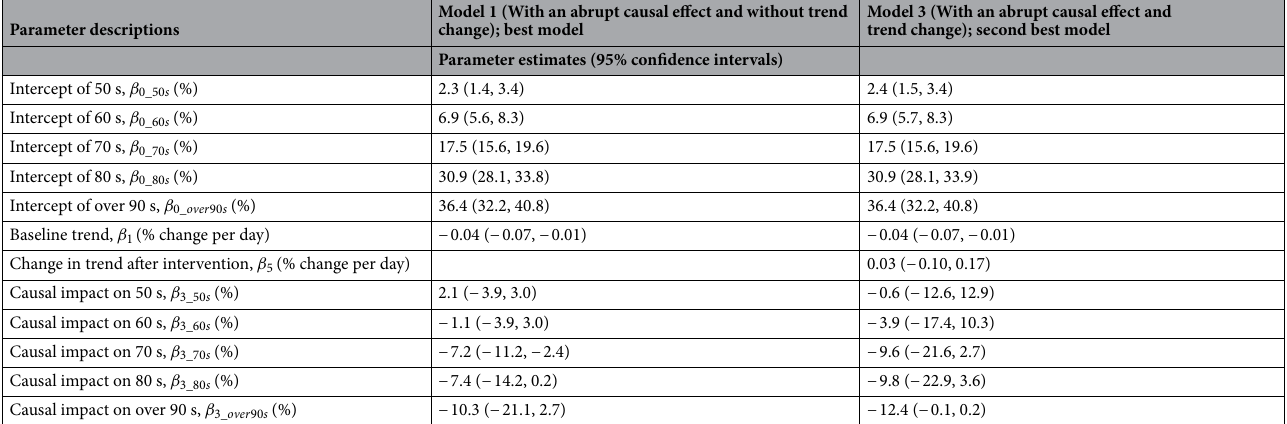
Table 2. Parameter estimates of models to describe the time-dependent variations in the case fatality risk of COVID-19 in Japan. β 0 , the parameter for the baseline level; β 1 , increase in the outcome following the time- unit increase; β 3 , the change in the level at the intervention (8 May 2020); β 5 , the change in trend following